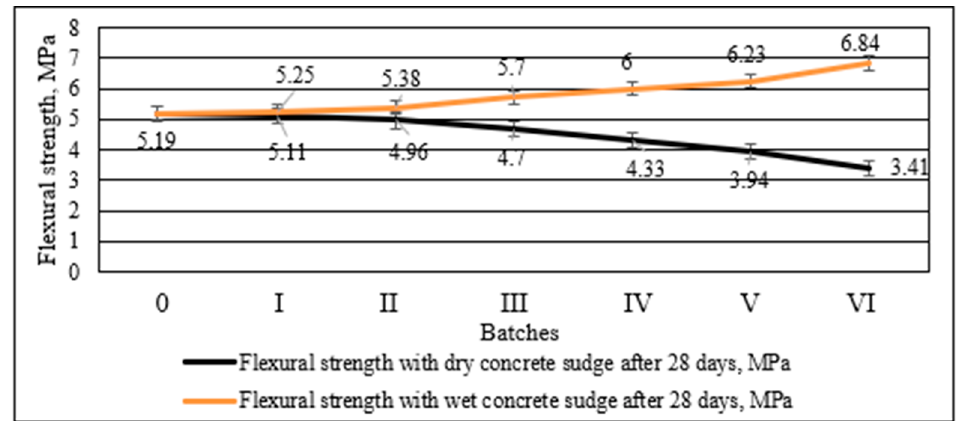
Figure 11. Flexural strength of concrete with different amounts of cement replacement with wet and dry concrete sludge after 28 days.